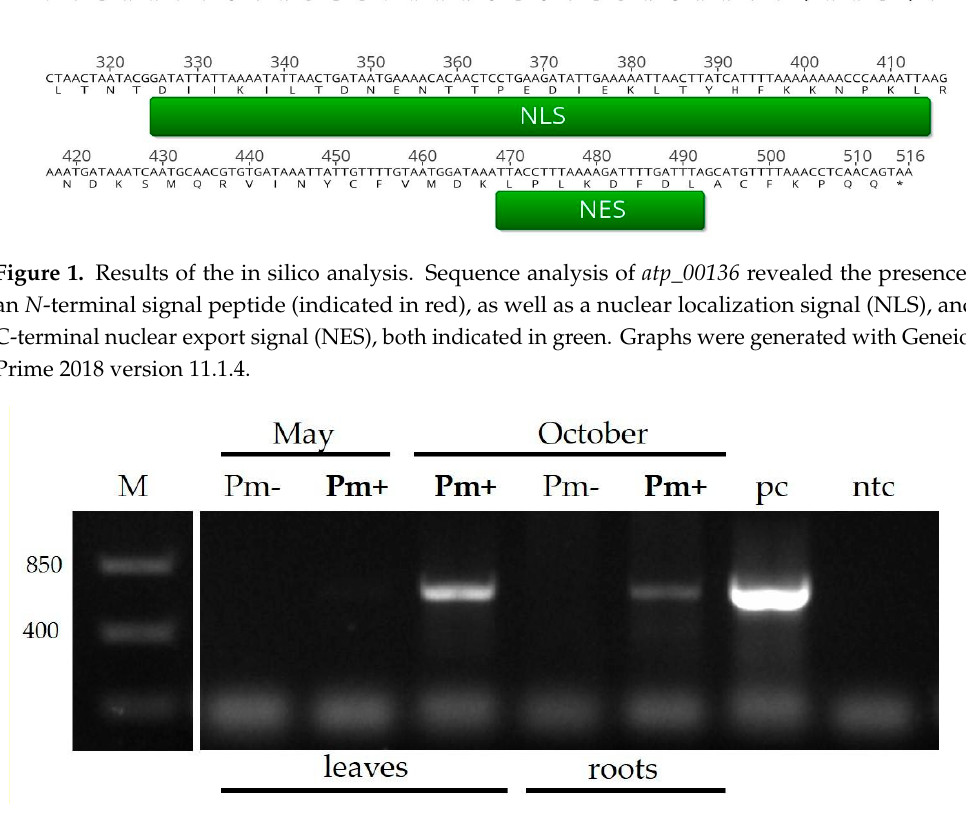
Figure 2. Expression of pme 2 (CAP18323.1) in ’ Candidatus Phytoplasma mali’ (P. mali)-infected Malus × domestica . Transcripts of pme 2 were detected by PCR using cDNA from Malus ×